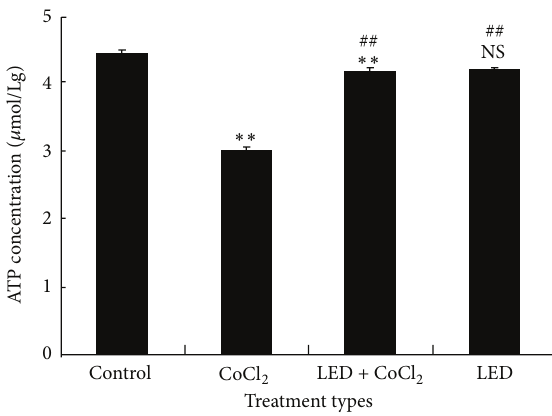
Figure 2: Effects of 670 nm LED irradiation with various power Figure 4: Effects of 21mW/cm 2 670 nm LED treatment on ATP densities on cell viability of RF/6A cells incubated with CoCl 2 at content. Data are means ± SEM. ∗∗ 𝑃 < 0.01 indicates comparison 200 𝜇 M for 24 h. Data are means ± SEM. ∗∗ 𝑃 < 0.01 indicates to control group. NS indicates no significantly difference compared comparison with control group. NS indicates no significance; ## 𝑃 < 0.01 indicates comparison with 200 𝜇 mol/L CoCl withcontrolgroup. ## 𝑃 < 0.01 indicatescomparisontoCoCl 2 2 group.